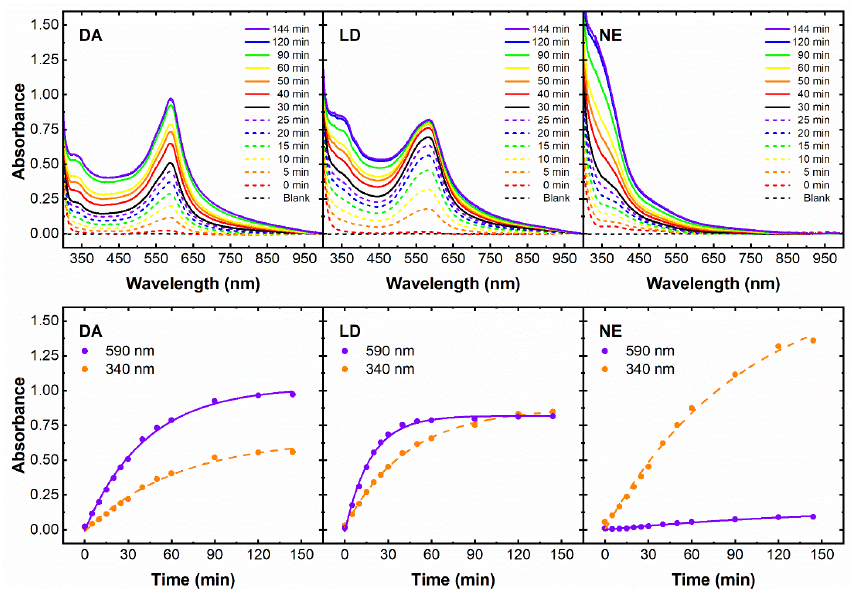
Figure 1. Time-dependent oxidation of natural catecholamines 0.2 g L − 1 in DMSO:H 2 O 1:1 ( v / v ) in the presence of 150 mM Mg(Ac) 2 , 150 mM NH4Cl at pH 9.4 and 25 °C between 2 min and 144 min. UV–Vis spectra (upper panels) and absorbance values (lower panels) at 340 nm (orange circles/dashed line) and 590 nm (purple circles/dashed lines) for dopamine (DA), levodopa (LD), and norepinephrine (NE).